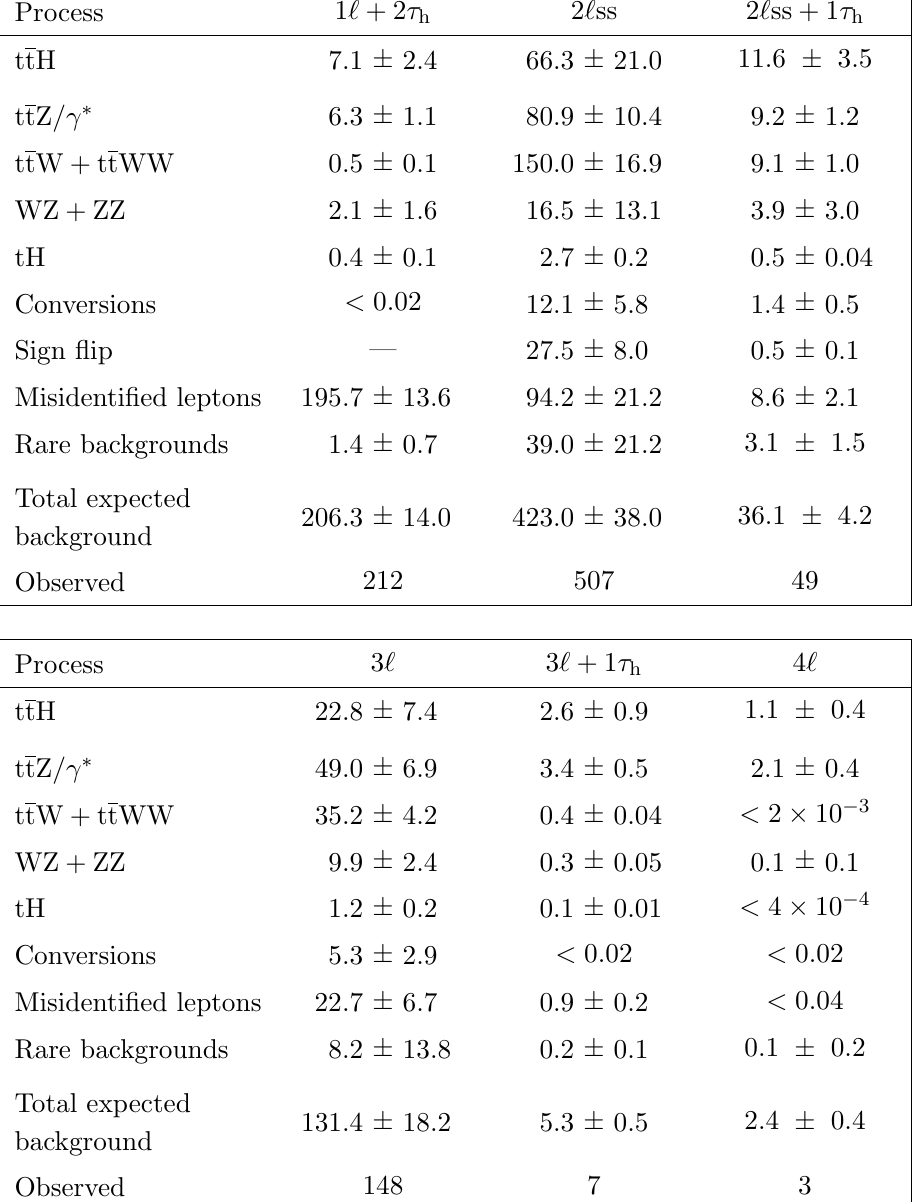
Table 5 . Numbers of events selected in the di(cid:11)erent categories compared to the SM expectations for the ttH signal and background processes. The event yields expected for the ttH signal and for the backgrounds are shown for the values of nuisance parameters obtained from the combined ML (cid:12)t and (cid:22) = ^ (cid:22) = 1 : 23. Quoted uncertainties represent the combination of statistical and systematic